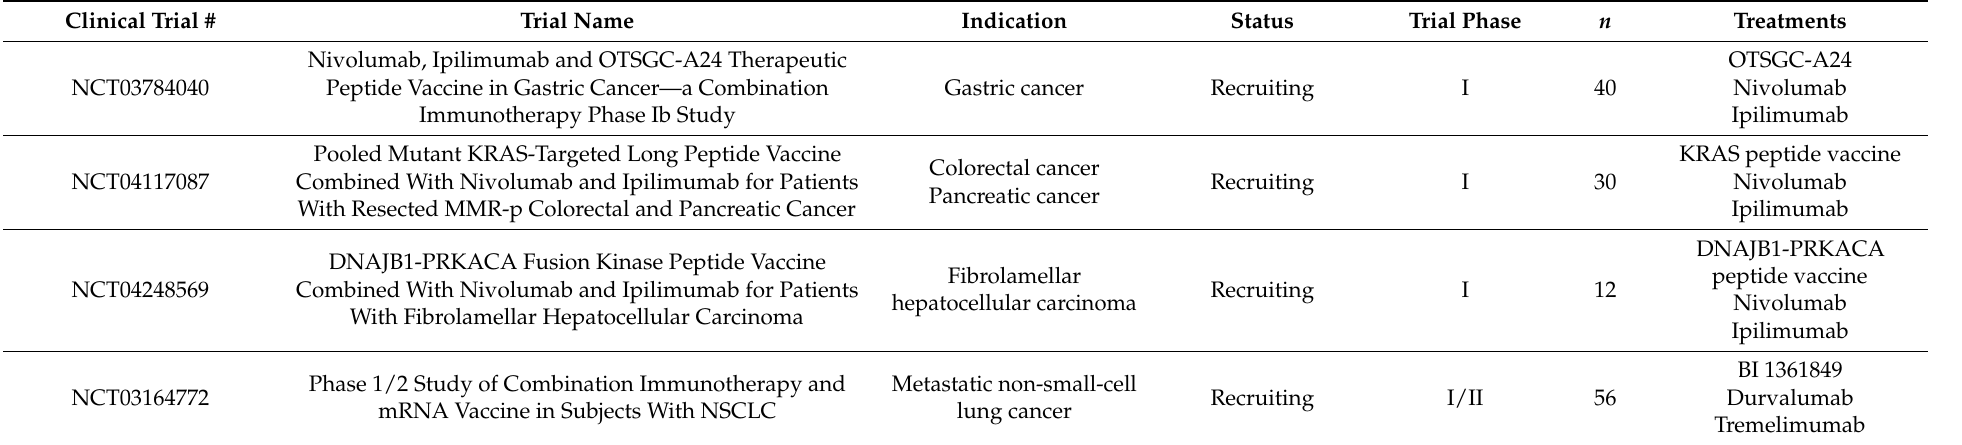
Table 1. Combining multiple checkpoint blockade antibodies with conventional cancer